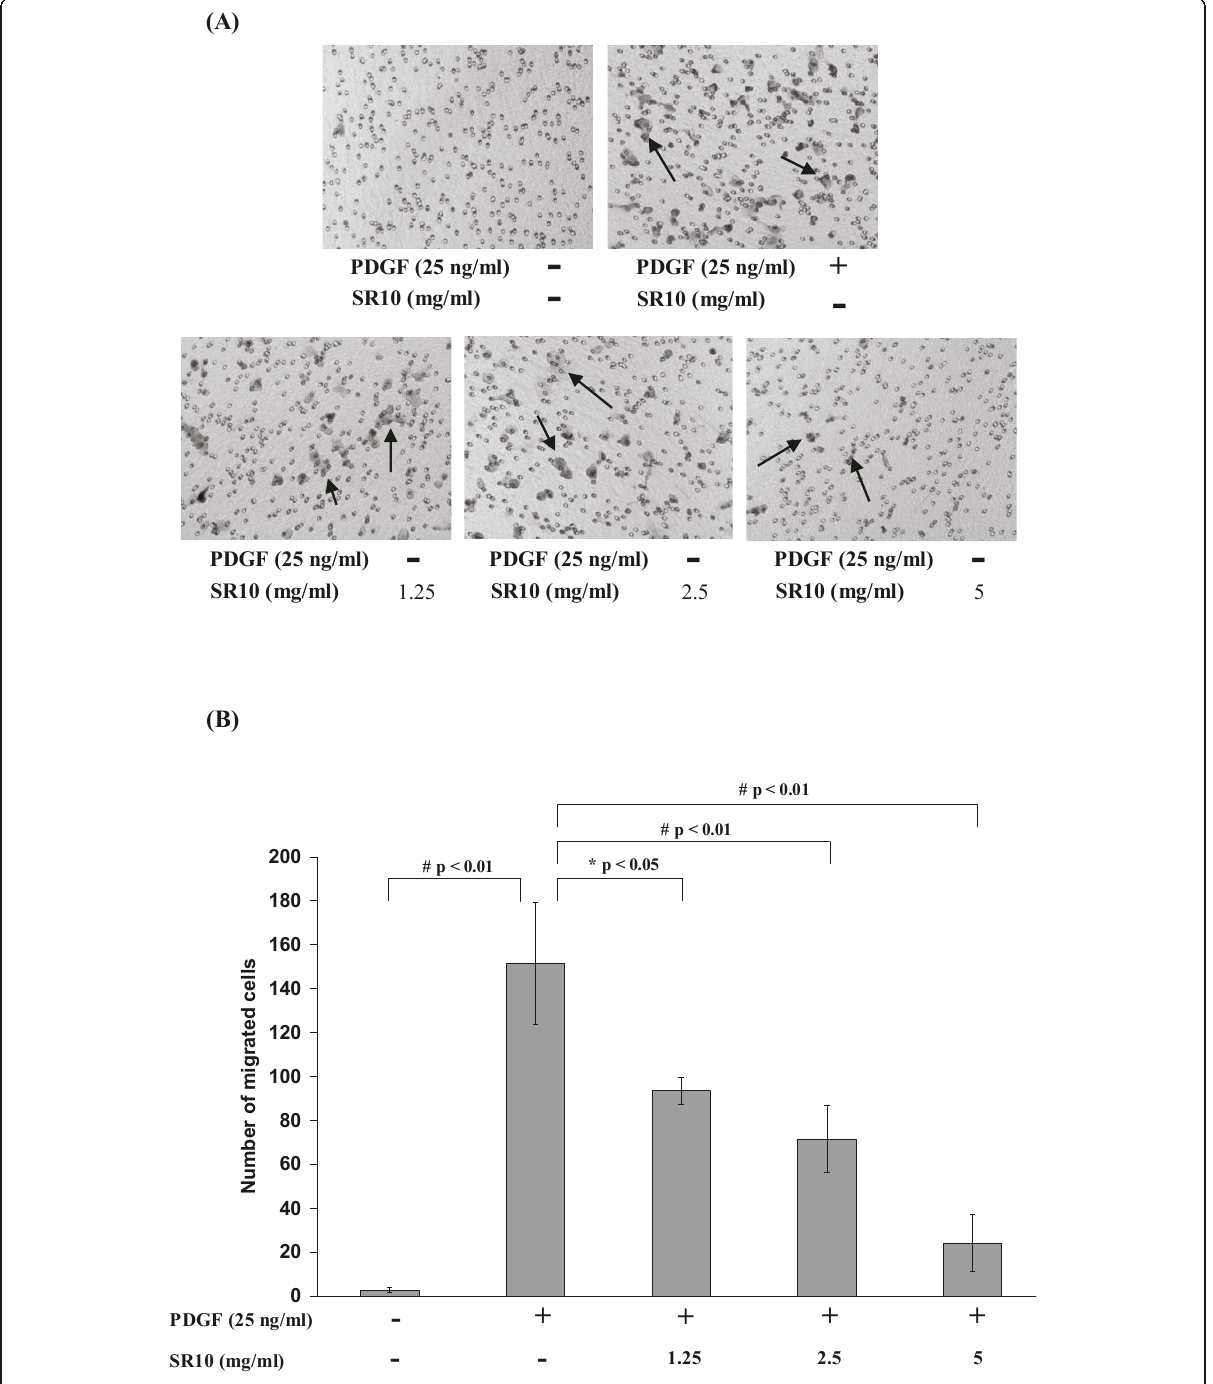
Figure 6 Effect of SR10 on PDGF-BB-induced migration of A7r5 cells in a transwell migration assay . A7r5 cells were loaded in the upper chamber while PDGF-BB (25 ng/ml) was loaded in the lower chamber in the absence or presence of various concentrations of SR10. After 3- hour incubation, migrated cells were observed in the lower surface of the membrane (A). Number of migrated cells was counted for five regions per filter. Data were expressed as mean ± S.D. with three replicates in each of three independent trials. By Mann-Whitney test, significant difference when compared to PDGF-BB alone was indicated by *p < 0.05 or # p < 0.01